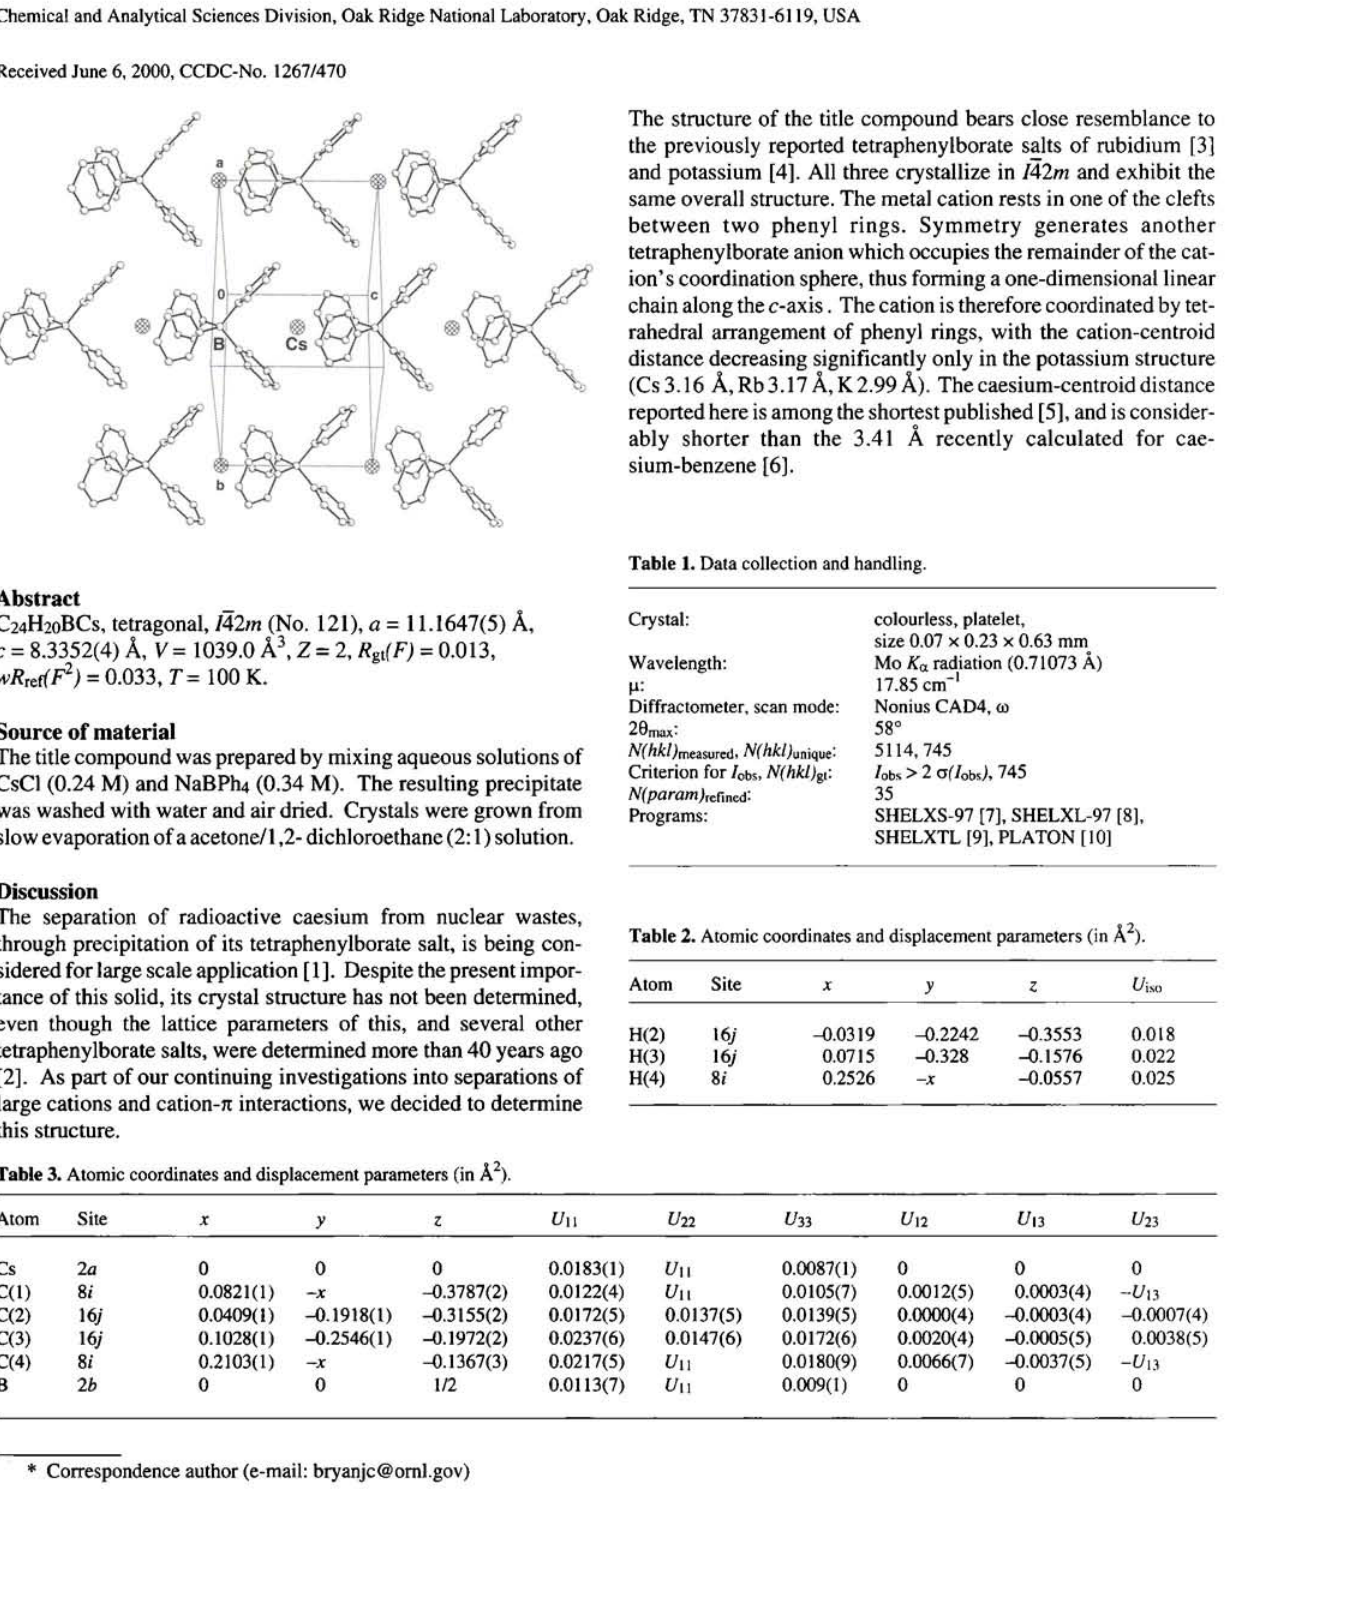
Table 3. Atomic coordinates and displacement parameters (in A 2 ).